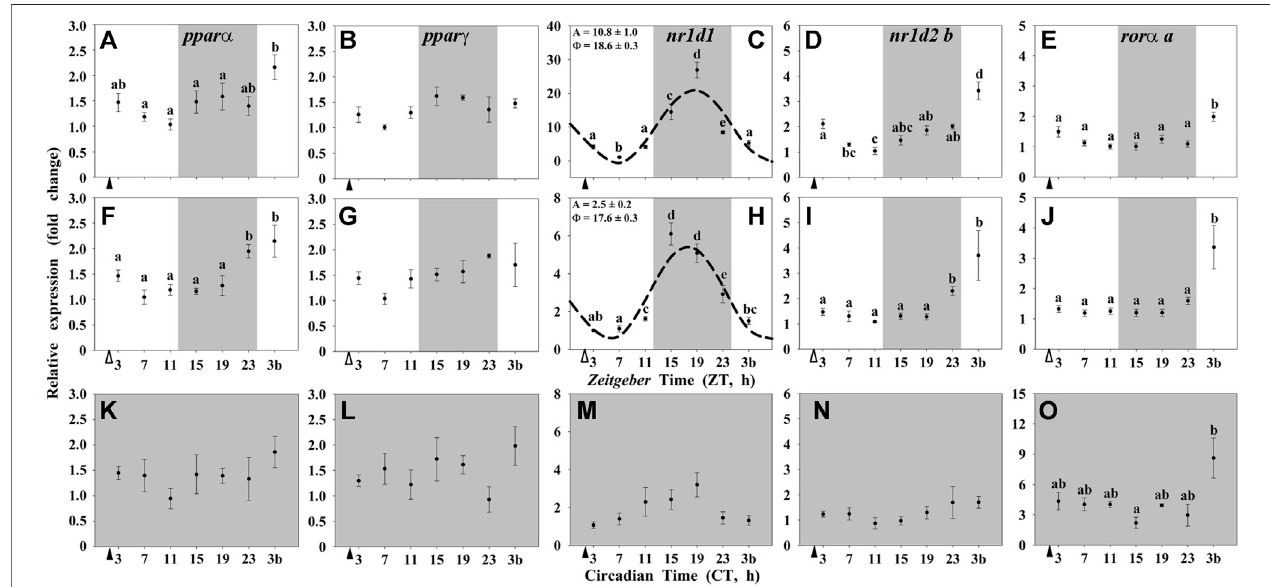
FIGURE3| Dailypro fi leofNRstranscriptsinthehypothalamusofgold fi shmaintainedunderdifferentlightingconditionsandfeedingprotocols.Greyareaindicates the dark period. Feeding timeisindicated bytrianglesin thex-axis (solid, ▲ , scheduled feedingat ZT/CT 2; white, Δ , random feeding withthe last meal at ZT 2). Dataare shown as mean ± SEM ( n = 5 – 7) in relative units (2 − ΔΔ Ct method). Different letters indicate signi fi cant differences (ANOVA p < 0.05, SNK post hoc test). When Cosinor ( SE(A)/A < 0.3 ) was signi fi cant and A > 1 , periodic sinusoidal functions were represented as dashed curves with the corresponding amplitudes and acrophases ( A and Φ , respectively).